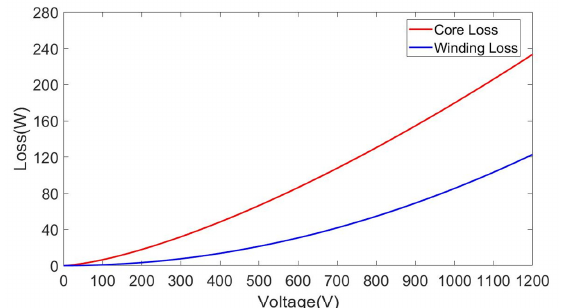
Figure 11. The trend of core loss and winding loss with voltage changing.